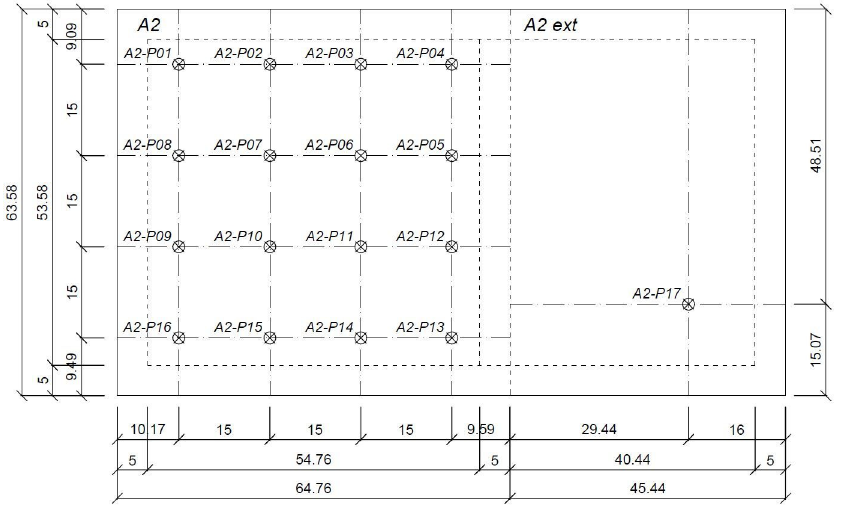
Figure 15. The embankment with marked settlement in measurement points from A2-P01 to A2-P17. The embankment loaded the subsoil. The load value was equal to σ 0 = 35